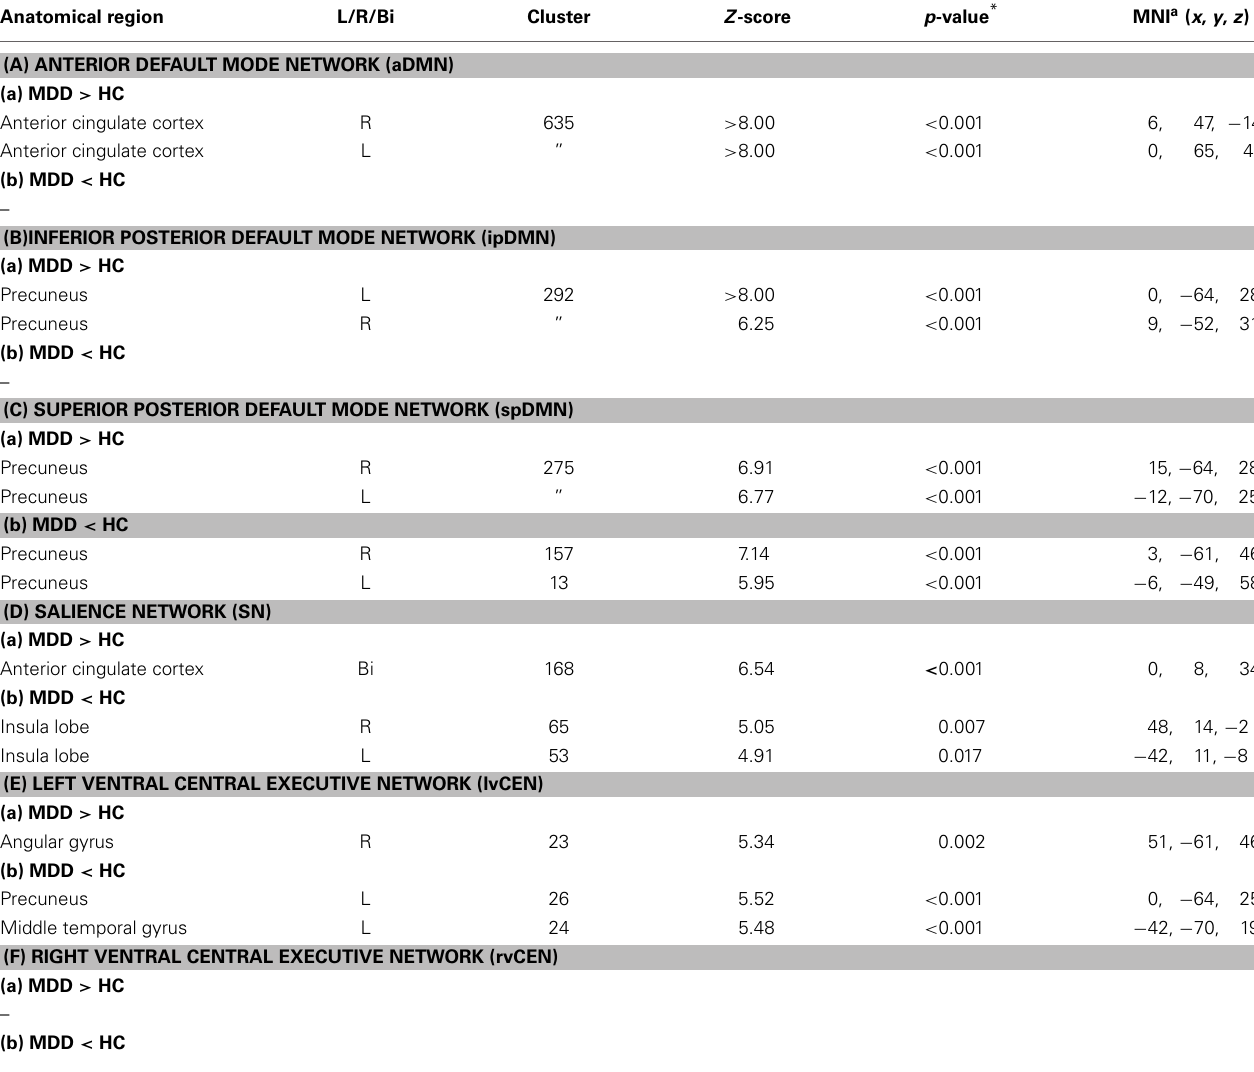
Table 3 | Altered intra-iFC in patients with major depressive disorder compared to healthy controls. Anatomical region L/R/Bi Cluster Z -score